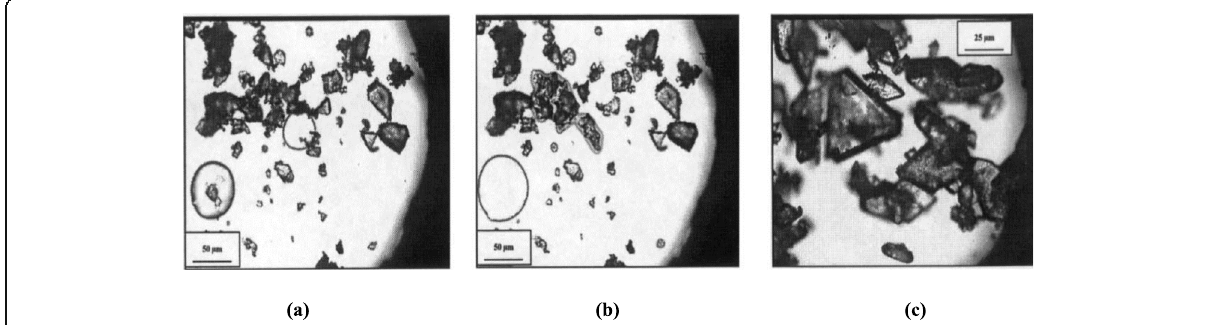
Fig. 9 HSM micrograph showing lacidipine and PEG 10 mixture at different temperatures . a lacidipine/PEG 10 at 145 °C; b lacidipine/PEG 10 at 169 °C; c lacidipine/PEG 10 at 180 °C. Lacidipine begins to dissolve in molten PEG 10 which signifies that both are compatible with each other. Reprinted from Forster et al. 2001 with permission from the